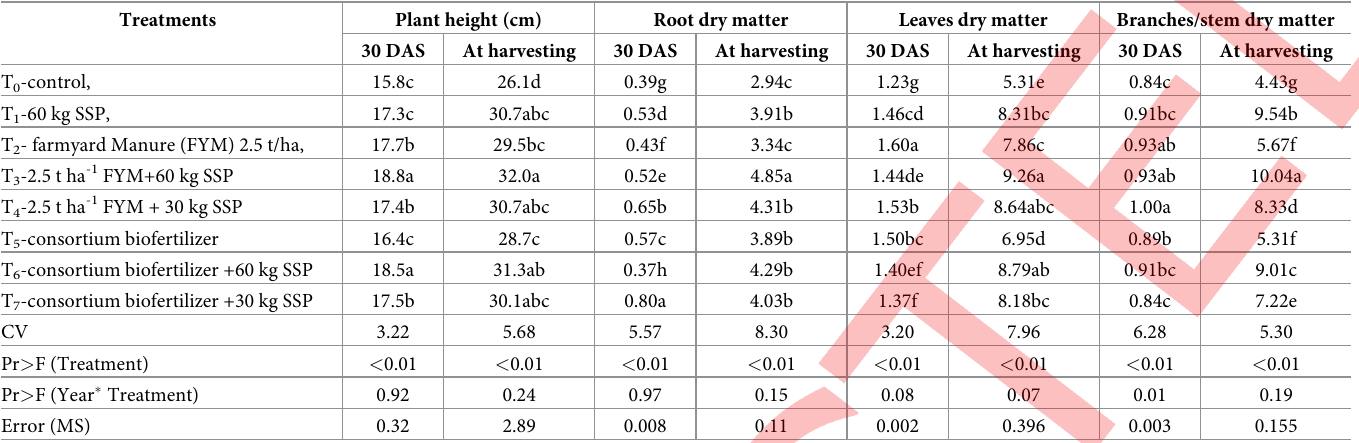
Phosphorus and soil physical environment. The accessibility of phosphorus also improves the utilization of N and K in the plant system. As phosphorus is involved in the energy cycle of plant in addition to its involvement in protein and lipids in the plant system, that help in improving plant growth. The data on the root dry matter accumulation in various treatments revealed that the early root growth of black gram at 35 DAS was significantly affected by the different combinations of source of phosphorus, FYM and biofertilizers (Table 2). The root dry mass at 35 DAS (days after sowing) was higher in the treatments where chemical fertilizer were integrated with the organic and biofertilizers such as T and T as compared to application biofertilizer, organic 7 4 manure and chemical fertilizer alone. The root dry matter at the harvesting stage was signifi- cantly higher in the treatment T where FYM was applied in addition to the full dose of phos- 3 phorus followed by use of biofertilizer and chemical fertilizers. Choudhary et al., [22] also reported beneficial effects of biofertilizer and organic manure on root growth and develop- ment. The recent studies had showed that phosphorus application enhanced root system resulting in better soil-root contact and finally higher P uptake and absorption of mineral nutrients [23].